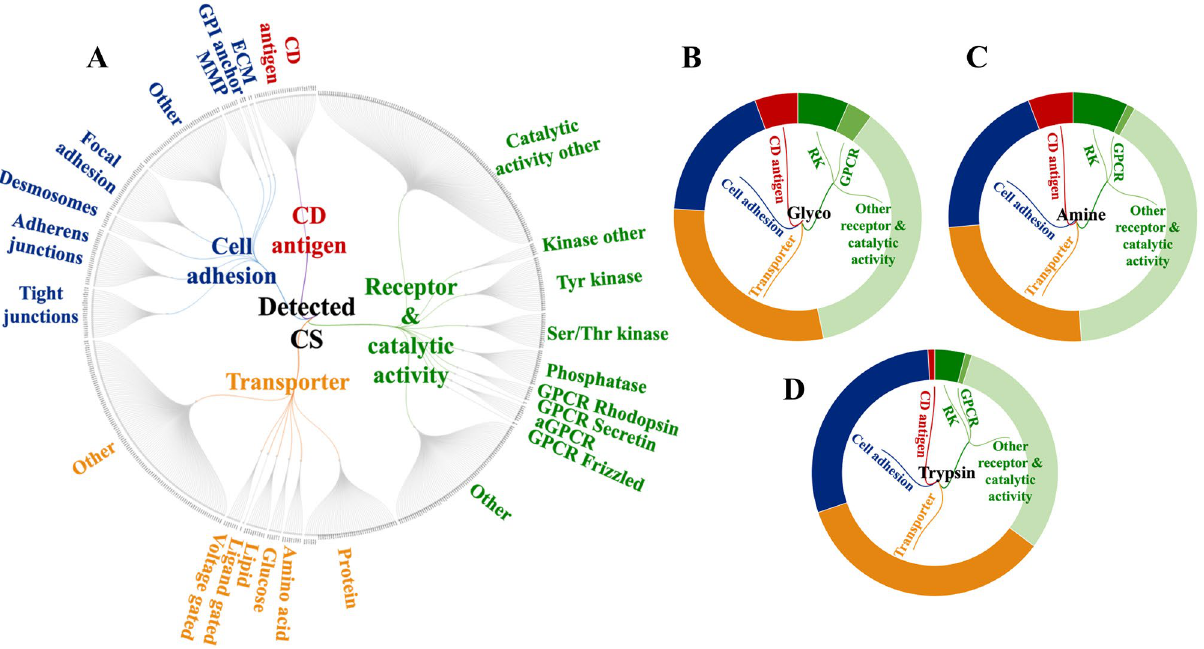
Figure 4. Functional categorization of the detected cell-membrane proteins based on GO controlled vocabulary terms (proteins detected by at least 2 unique peptides, FDR < 3%). ( A ) Dendrogram of cell-membrane proteins detected by all labeling methods and conditions. ( B ) (C), and ( D ) Doughnut charts of detected cell-membrane proteins enriched via glycoprotein labeling, amino group labeling, and tryptic shaving methods,